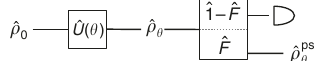
Fig. 2 Preparation of postselected quantum state. First, an input quantum undergoes a unitary transformation ^ U ð θ Þ ¼ e (cid:3) i θ ^ A : ^ ρ state ^ ρ 0 the quantum state is subject to a projective postselective measurement ^ F ; ^ 1 ^ F f (cid:3) g . The postselection is such that if the outcome related to the operator ^ F happens, then the quantum state is not destroyed.